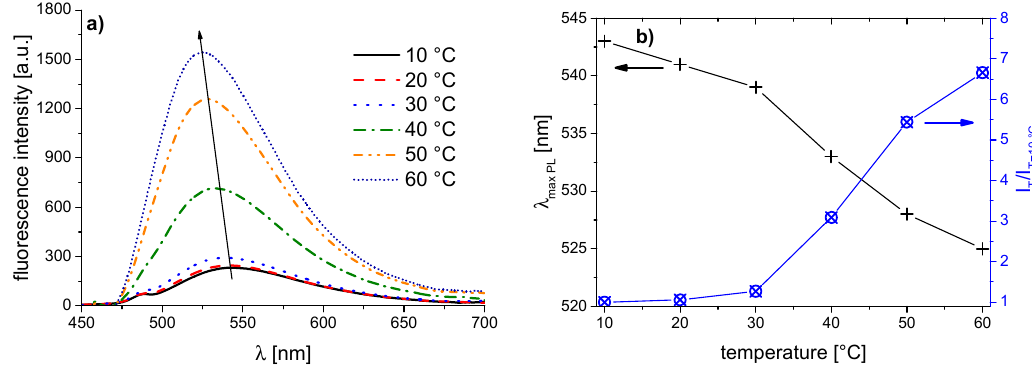
Figure 10. Temperature dependent fluorescence behavior of PNVCL-f in aqueous solution (concentration 0.10 g·L − 1 ): ( a ) normalized emission spectra ( λ Exc = 418 nm); and ( b ) evolution of λ maxEm of the emission band, and of the fluorescence intensity normalized to 10 °C.